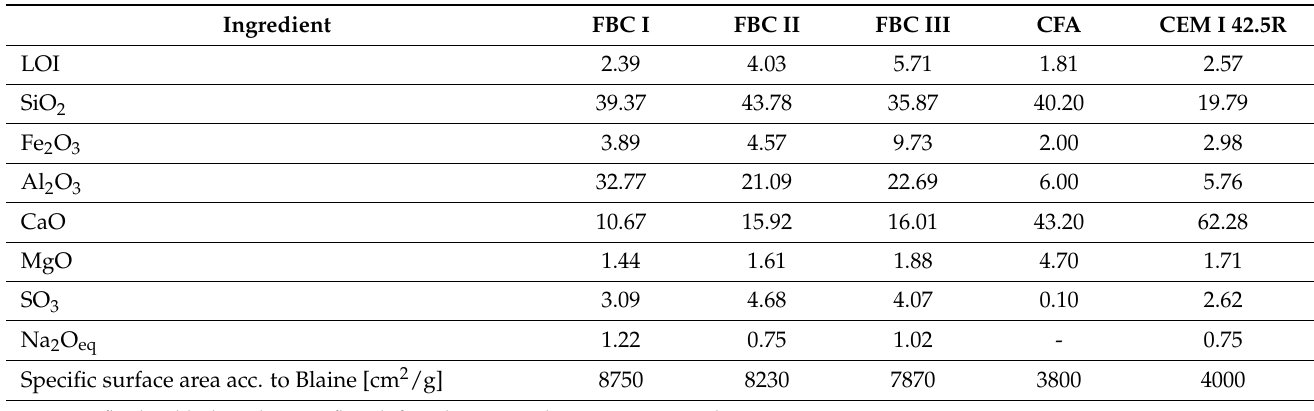
Table 2. Chemical composition of fluidized bed combustion fly ashes (FBC I, FBC II, FBC III) and siliceous fly ashes (CFA).